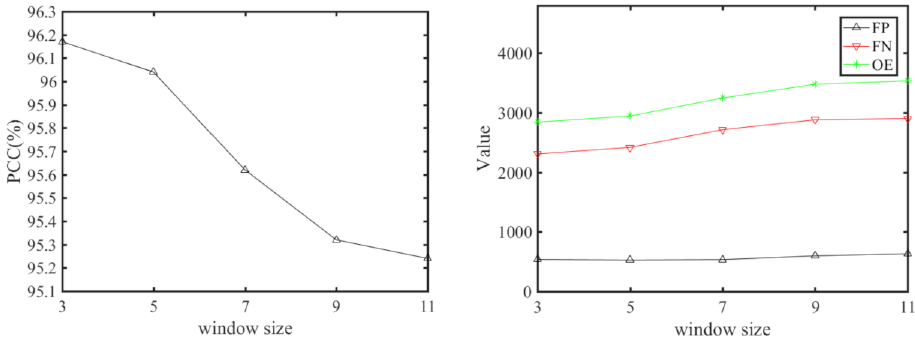
Figure 25. The influence of w (Window Size of the Filter) evaluated on the Farmland D